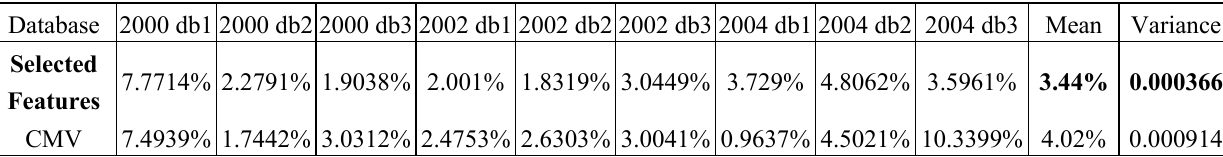
Table 5. Segmentation error rates